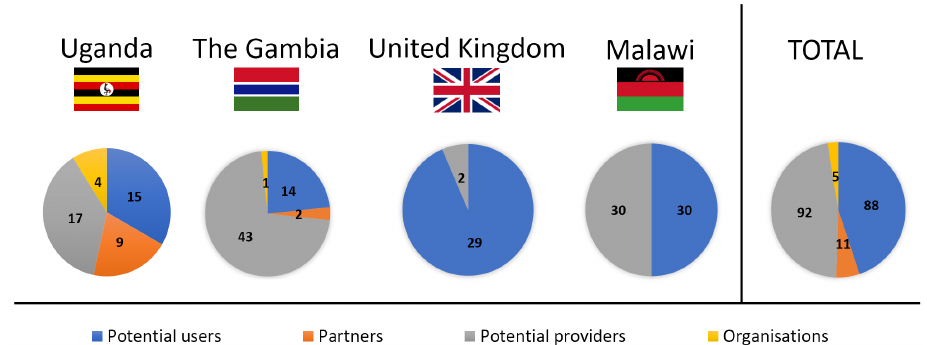
Figure 3. Participants in the study grouped by country. Four different groups were included in focus group discussions and semi- structured interviews: potential users (blue), partners of potential users (orange), potential providers (grey) and organisations that provide family planning